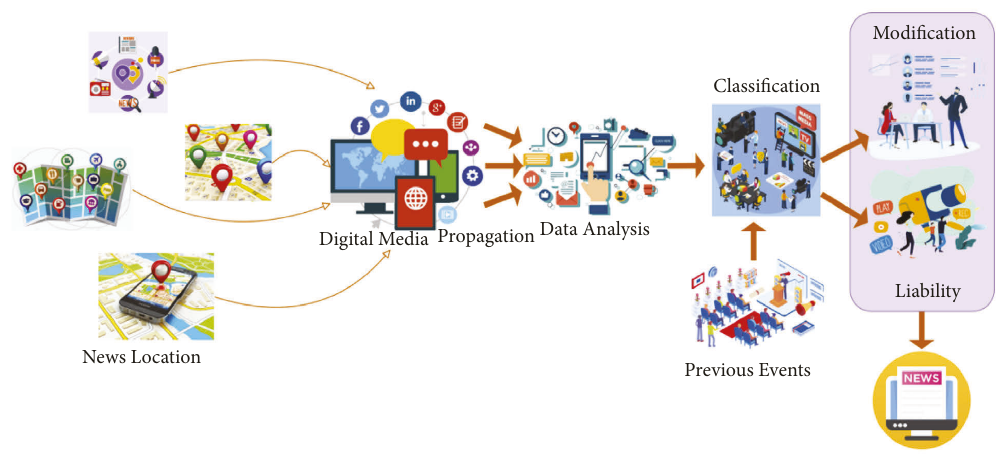
Figure 1: Proposed EDP